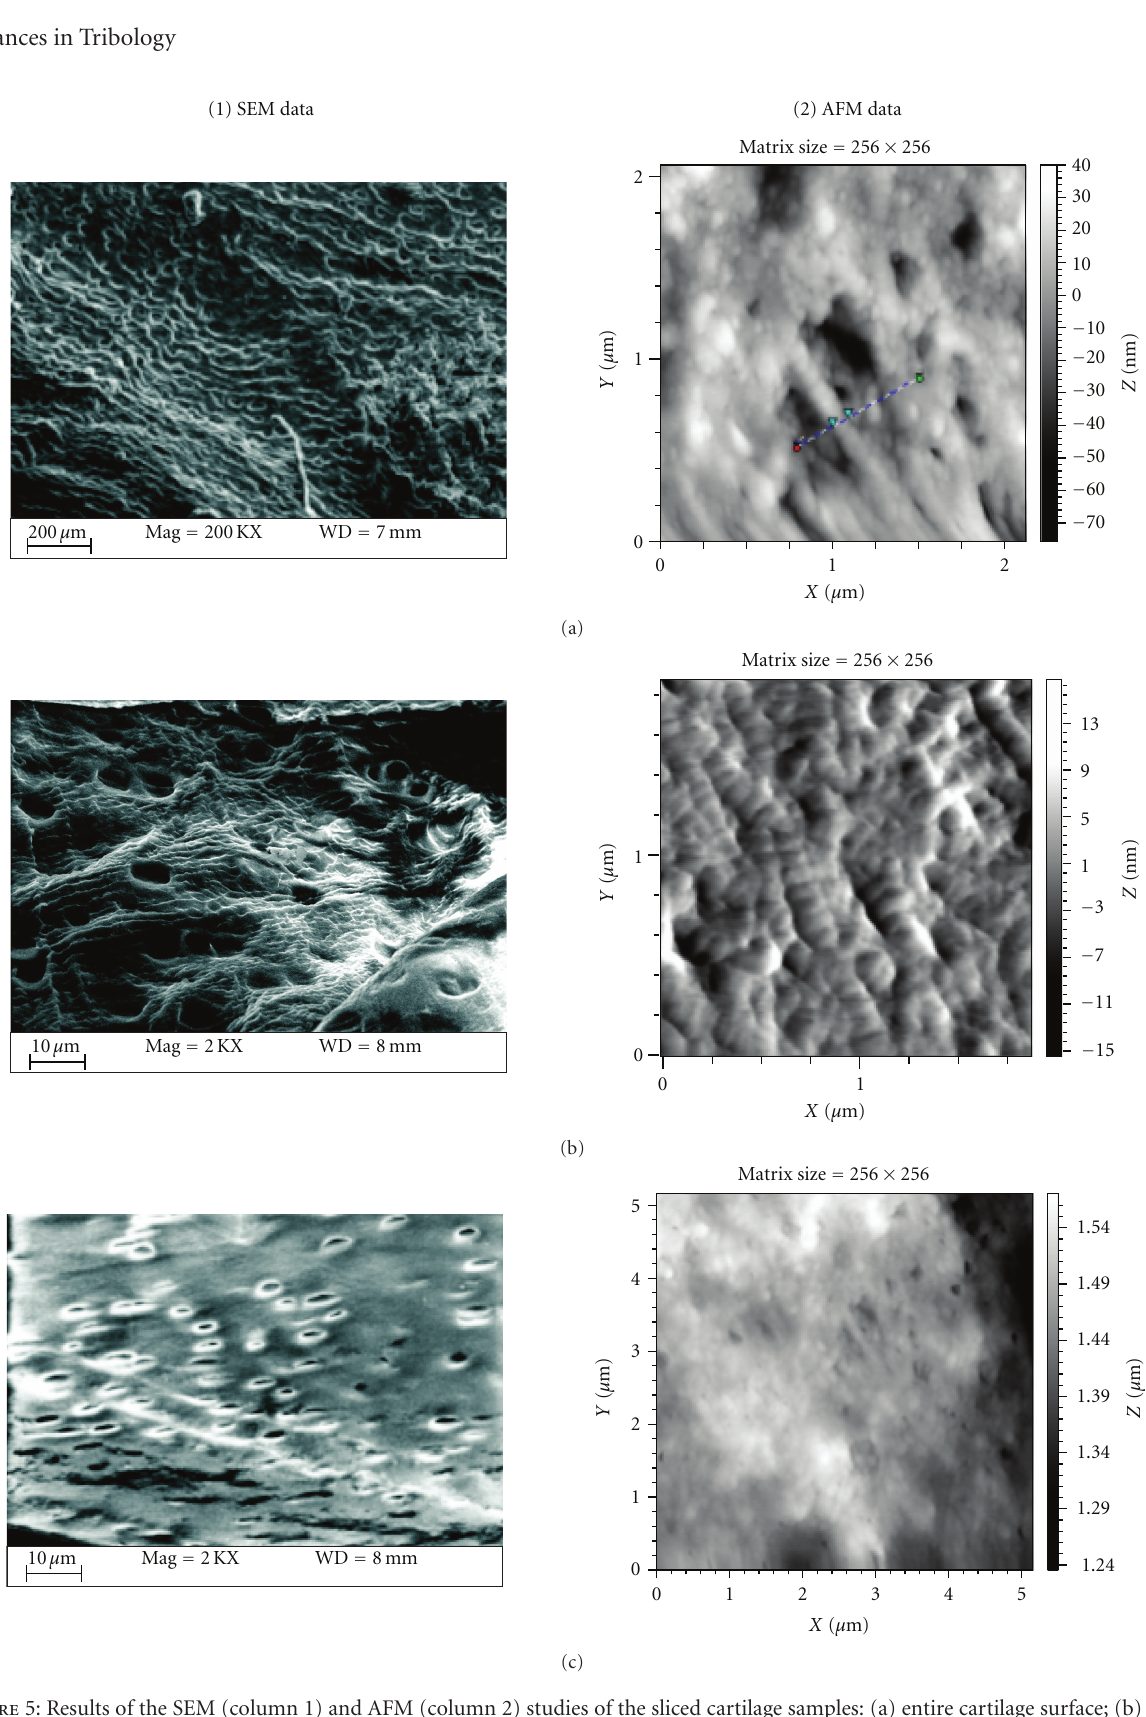
Figure 5: Results of the SEM (column 1) and AFM (column 2) studies of the sliced cartilage samples: (a) entire cartilage surface; (b) radial slice surface; (c) tangential slice surface. SEM images scale bars are: (a) 100 micron; (b) 10micron; (c) 10 micron. AFM images scan sizes are: (a) 2 . 2 × 2 . 2micron; (b) 1 . 7 × 1 . 7micron; (c) 5 . 2 × 5 .